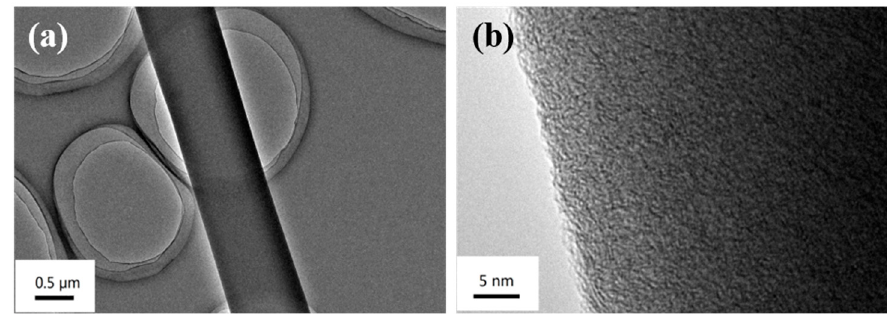
Figure 2. Low-magnification ( a ) and high -magnification ( b )TEM images of MPCNF-750.